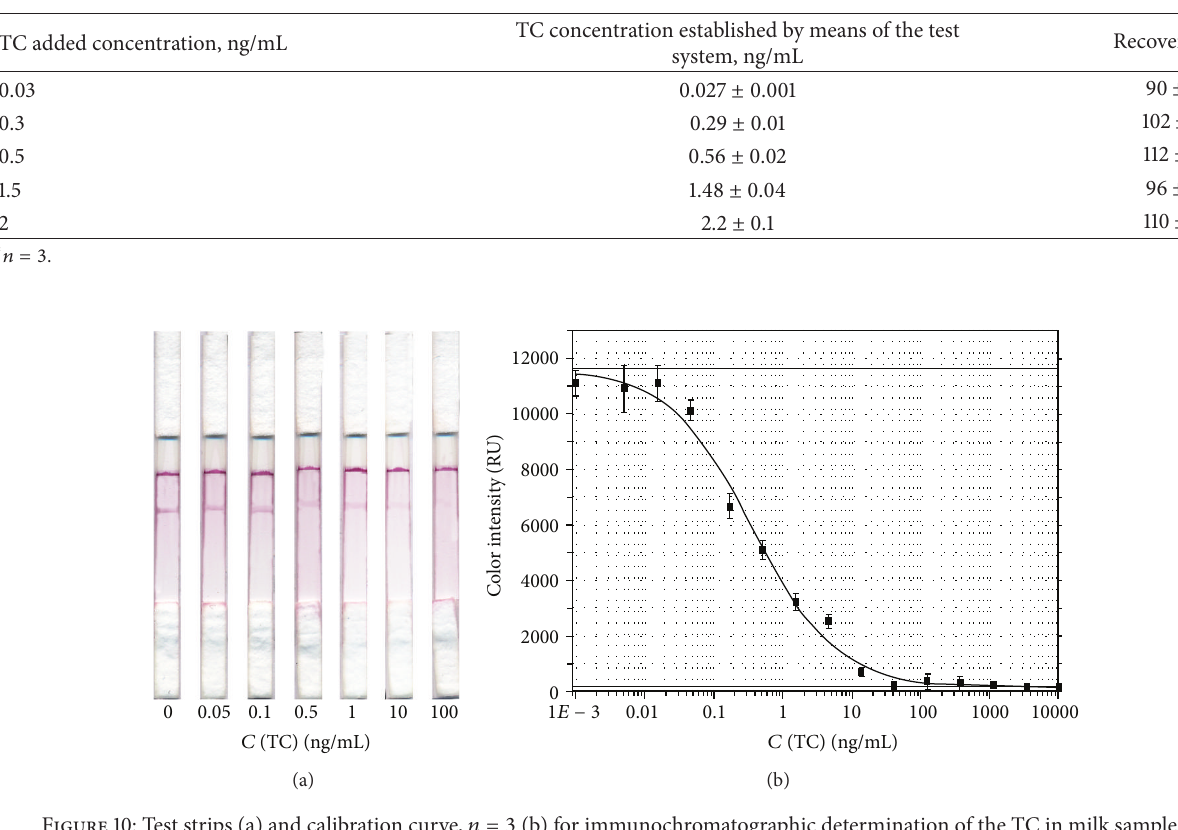
Table 3: Description of the test system developed for TC for testing milk samples in “addition-detection” experiments.